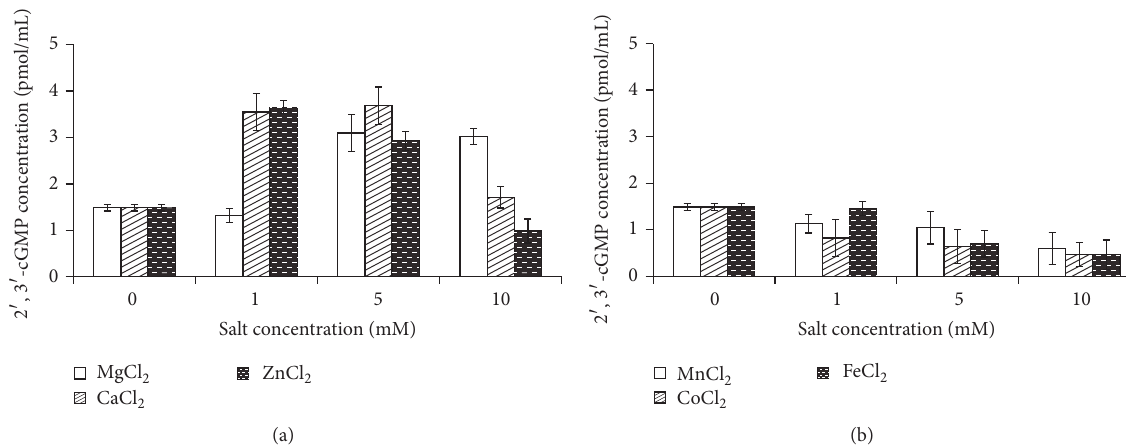
Figure 3: The impact of nontransition ( 1 ) and transition (b) metal ions on the rate of 2 󸀠 ,3 󸀠 -cGMP during catalytic cleavage of RNA by binase.